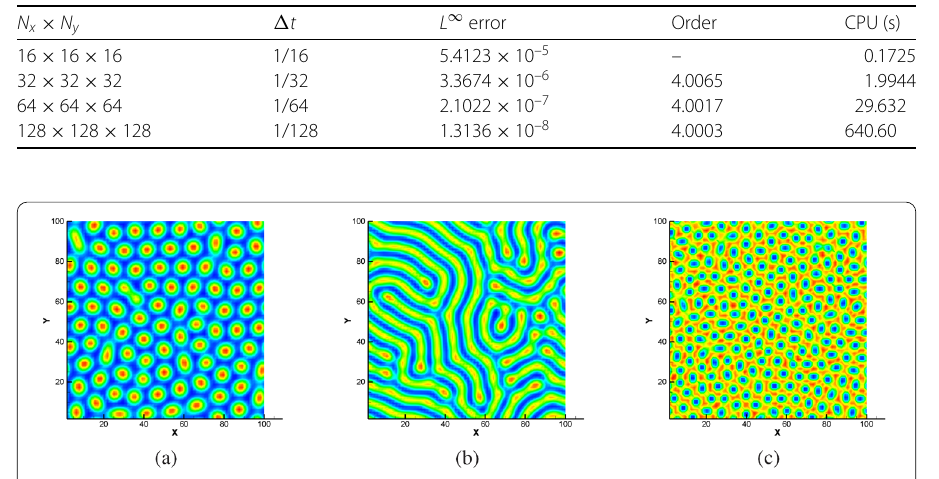
Figure 1 H 0 hexagon, stripe, and H π hexagon pattern of CIMA model at t = 10 4 for 2D